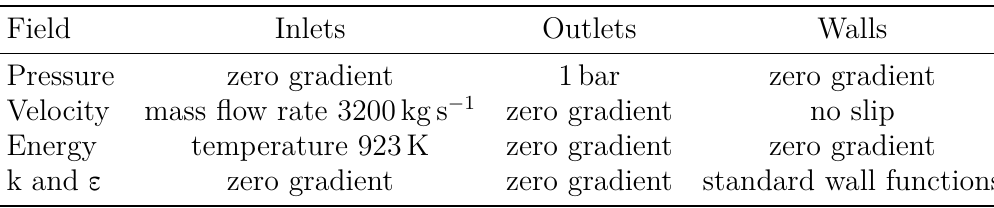
Table II: Fluid dynamics boundary conditions